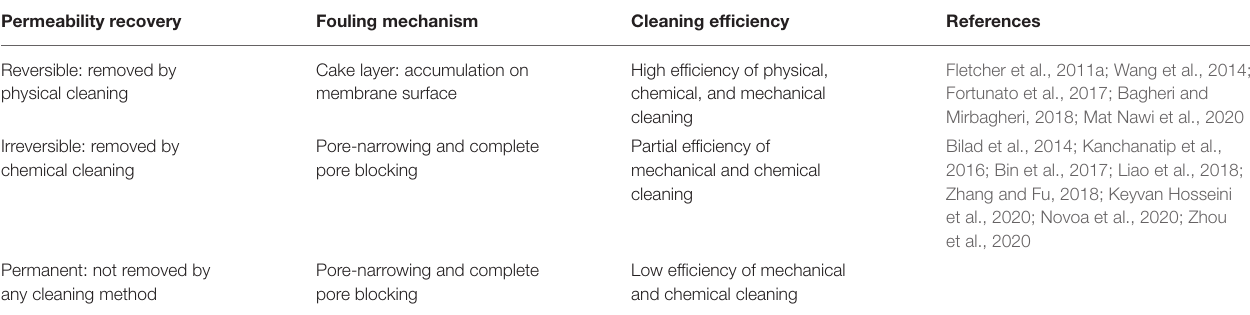
TABLE 1 | Definitions in fouling classification according to the permeability recovery, fouling mechanism, and cleaning